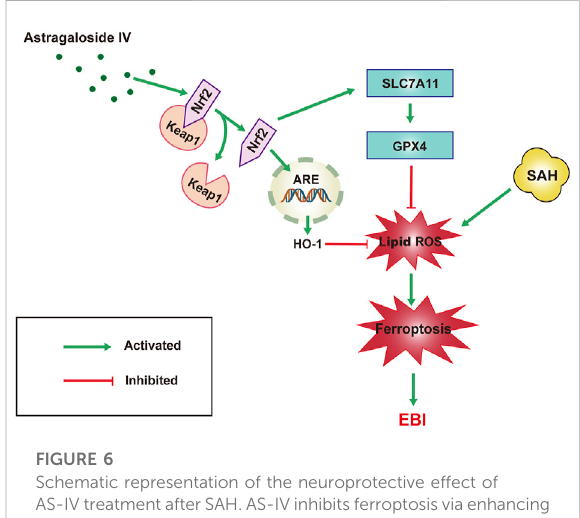
FIGURE 6 Schematic representation of the neuroprotective effect of AS-IV treatment after SAH. AS-IV inhibits ferroptosis via enhancing Nrf2/HO-1 signaling pathway, thereby ameliorating EBI 24 h after SAH in